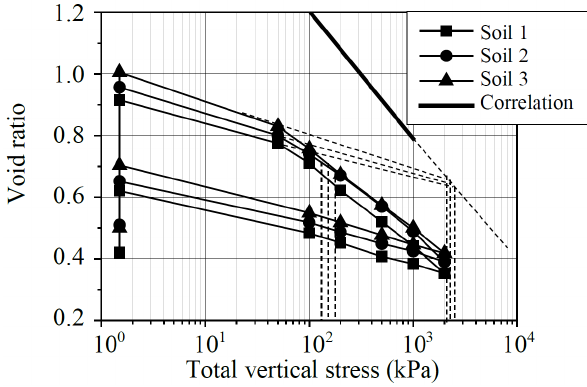
Figure 3: Oedometric test on slurry with wi ≥ 1.2 LL (Test: OT1) and on Consolidated soil at 100 kPa (Test: OT2).